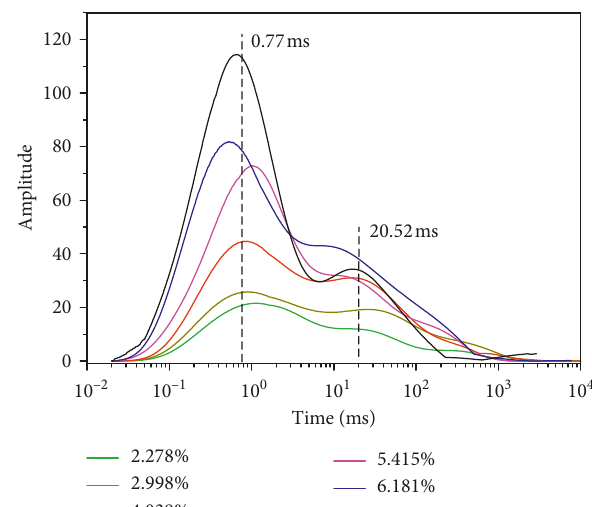
Figure 3: T 2 spectral distribution curve.